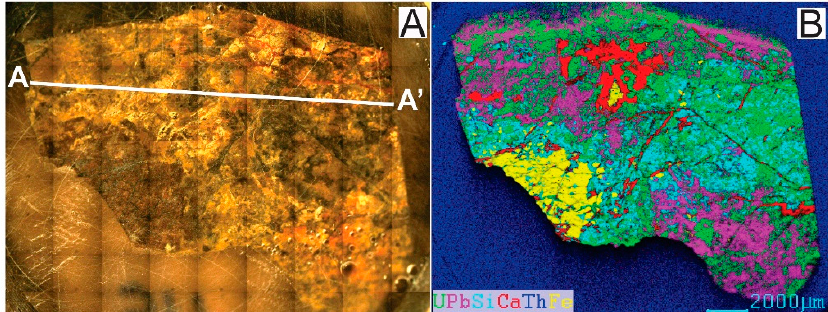
Figure 1. Sample image ( A ) and micro-XRF major element map ( B ) for Rabbit Lake uraninite (#511) illustrating typical compositional changes observed in samples investigated here (Tables S1 and S2). Line A to A’ demonstrates a typical transect that was chosen to investigate both pristine and altered sections of each sample.